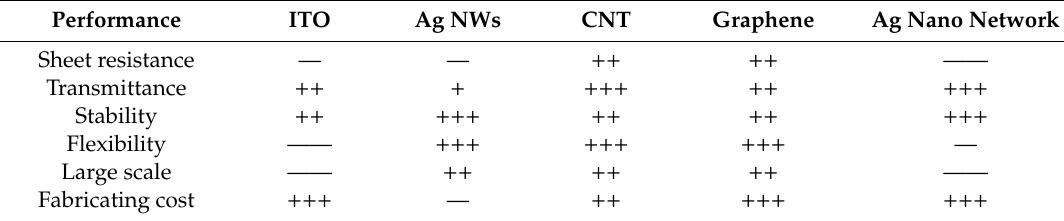
Table 1. Comparison of properties of several